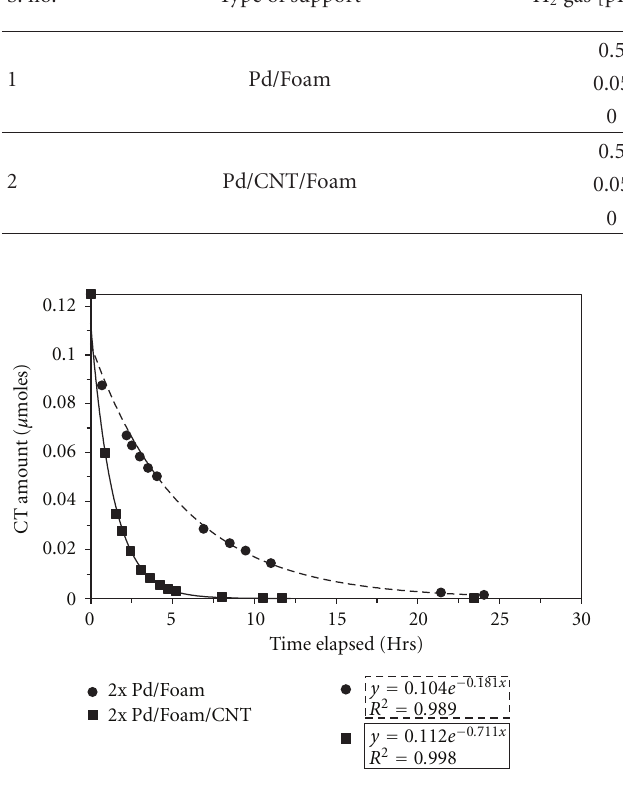
Figure 4: Carbon tetrachloride (CT) degradation curves with exponential curve fitting obtained for twice the amount of Pd nanoparticle catalysts (two pieces of Pd/Foam and Pd/CNT/Foam), 2x Pd/Foam and 2x Pd/CNT/Foam